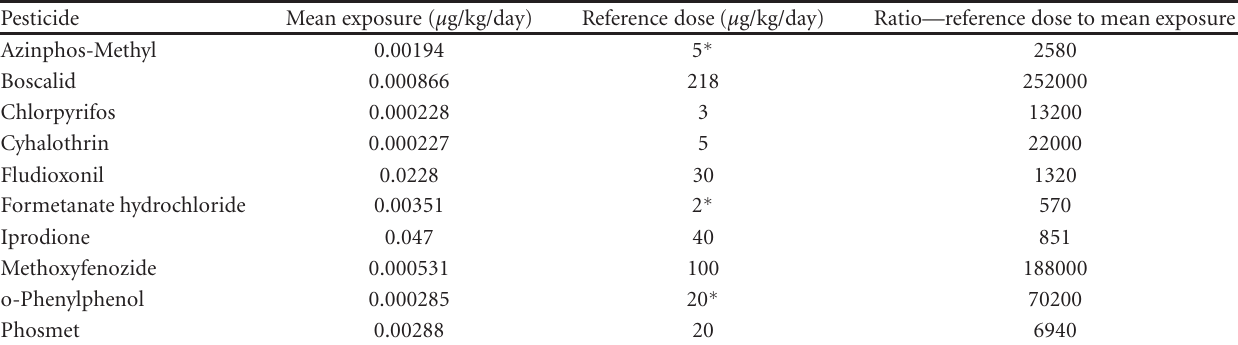
Table 10: Exposure estimates of the ten most frequently detected pesticides on